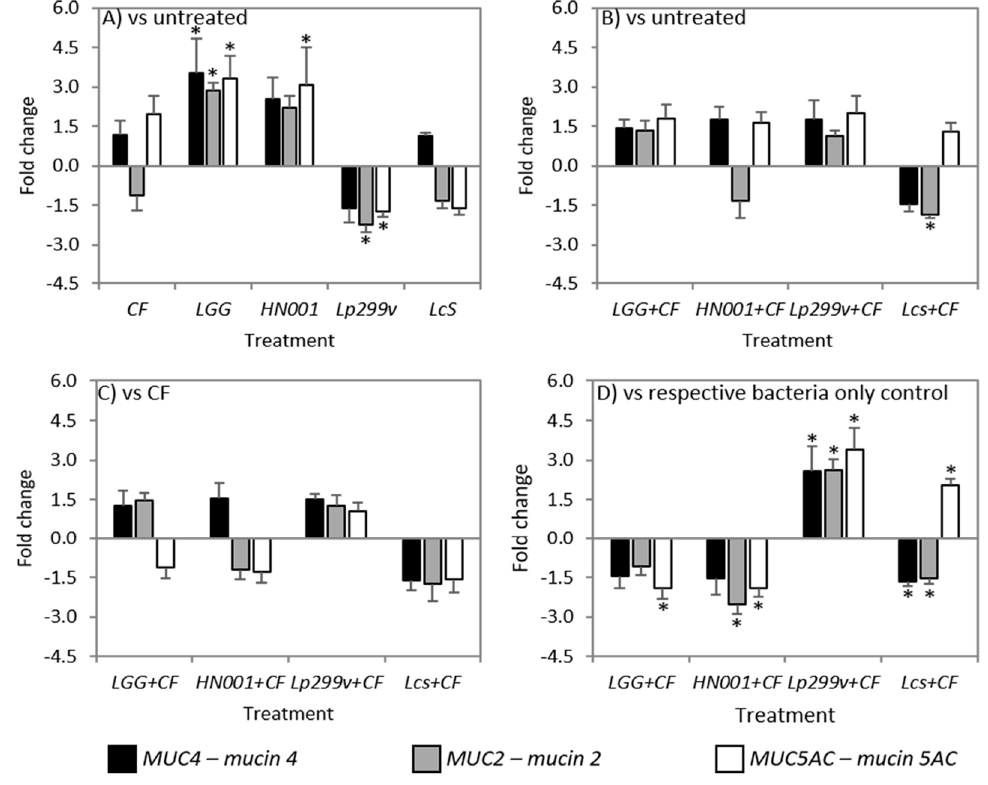
Figure 6. Fold change of MUC4 , MUC2 , and MUC5AC mRNA from Caco-2:HT29–MTX (90:10) co-cultures after 3 h incubation with ( A ) probiotic bacteria or a carbohydrate fraction (CF) relative to untreated co-cultures; ( B ) bacteria/CF combinations compared to untreated monolayers; ( C ) bacteria/CF combinations compared to monolayers incubated with CF; and ( D ) bacteria/CF combinations relative to bacteria only controls. Data are expressed as the mean fold change ( ± SEM) of three replicates across three independent experiments; n = 3 A statistically significant difference in fold change at ± 1.5 is indicated by * ( P < 0.05). LGG = L. rhamnosus GG; HN001 = L. rhamnosus HN001; Lp299v = L. plantarum 299v and LcS = L. casei